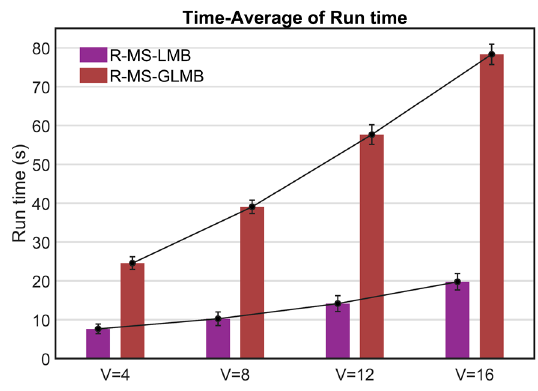
Figure 10. Average runtime for di ff erent S/R pairs.